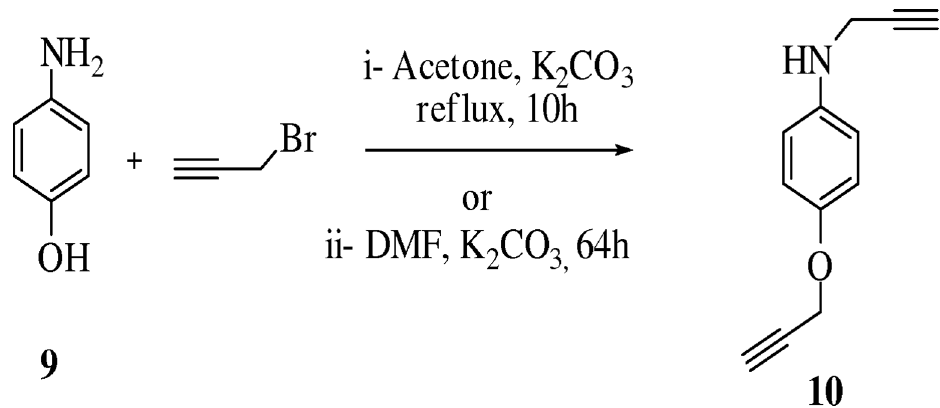
Fig. 5. Synthesis of compound 10.